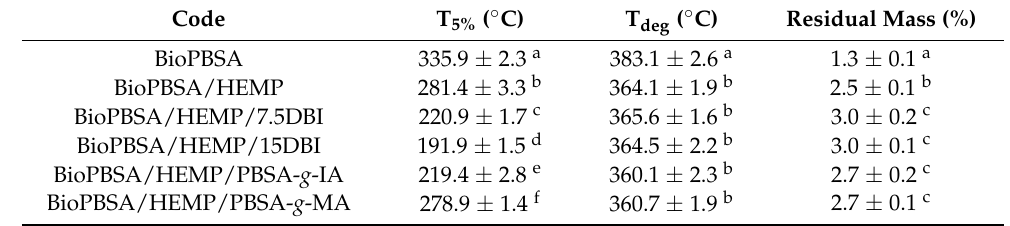
Figure 4. ( a ) Thermogravimetric analysis (TGA) curves and ( b ) first derivative (DTG) of BioPBSA/HEMP composites. Table 4. Main thermal degradation parameters of the BioPBSA/HEMP composites in terms of the onset degradation temperature at a mass loss of 5 wt.% (T 5% ), maximum degradation rate (peak) temperature (T deg ), and residual mass at 600 °C.